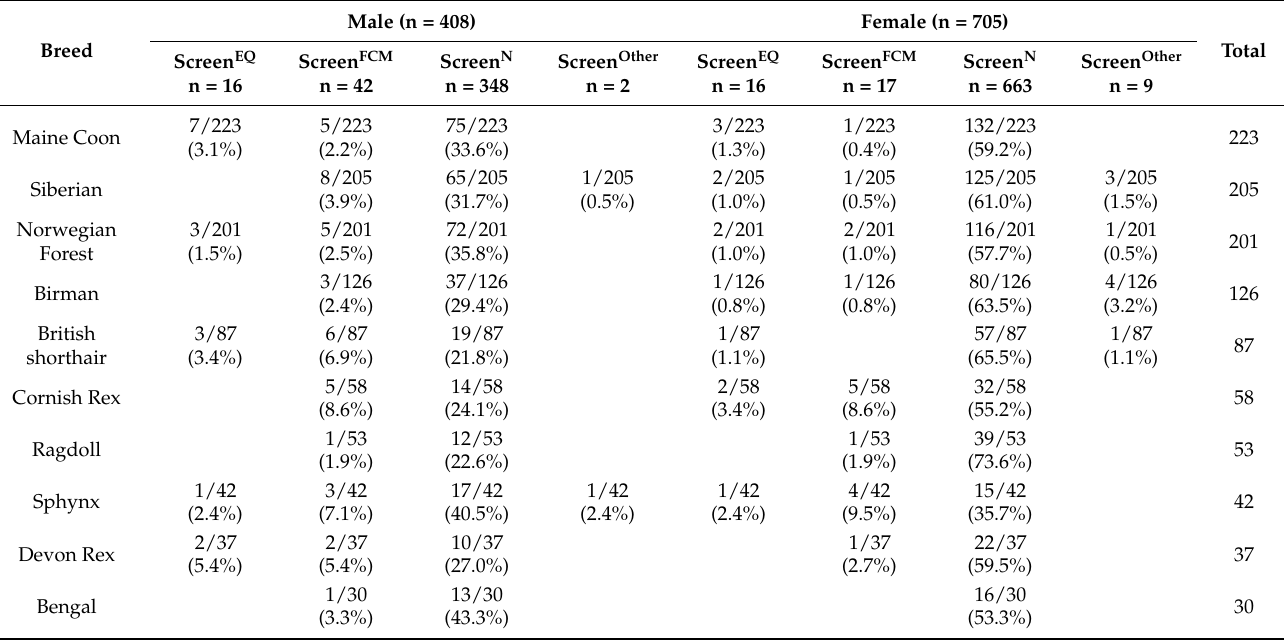
Figure 1. Flow chart describing reasons for excluding cats to create the study population. Table 1. Summary statistics for the 1113 cats included in the study by sex, breed-screen classification, and breed.